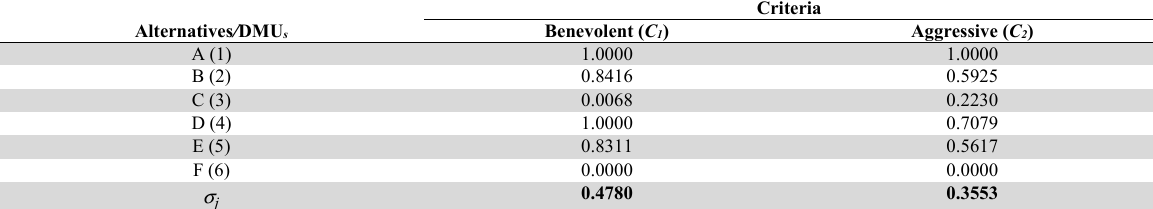
Normalized decision matrix of six nursing homes